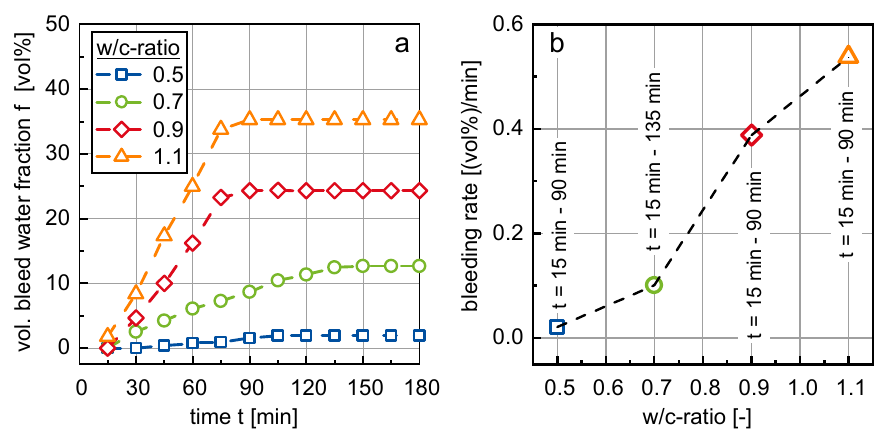
Figure 6. ( a ) Development of the bleed water volume over time and ( b ) bleeding rate as a function of the w/c-ratio.